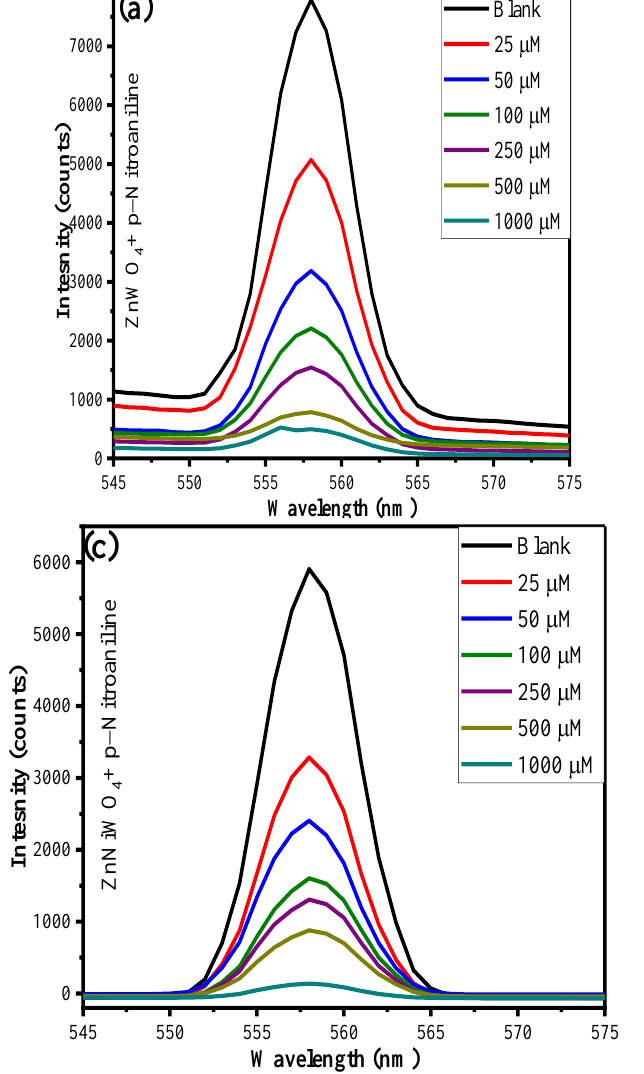
Figure 10. Effect of varying p-NA concentrations on fluorescence intensity of ( a ) ZnWO 4, ( b ) NiWO 4, and ( c ) ZnNiWO 4, recorded at 320 nm excitation wavelength.